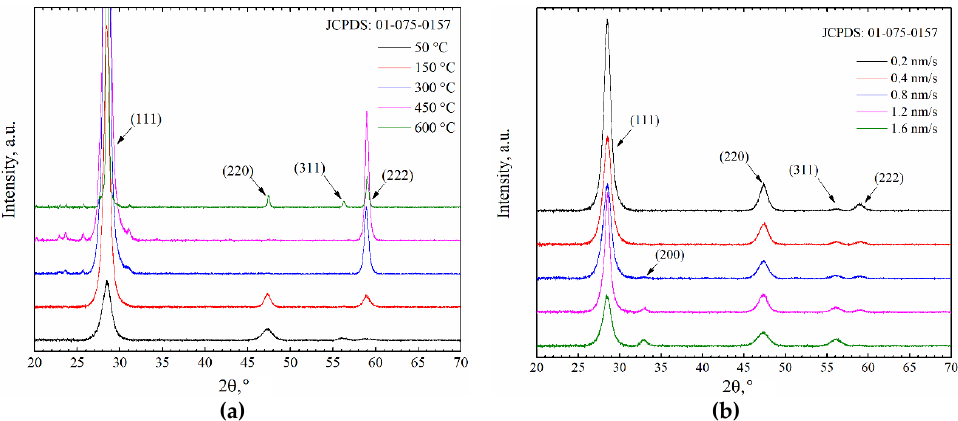
Figure 4. XRD patterns of SDC20 thin films deposited on SiO 2 substrates at (a) a 0.4 nm/s deposition rate and different substrate temperatures; (b) temperature of the substrate, 50 °C, at different deposition rates.